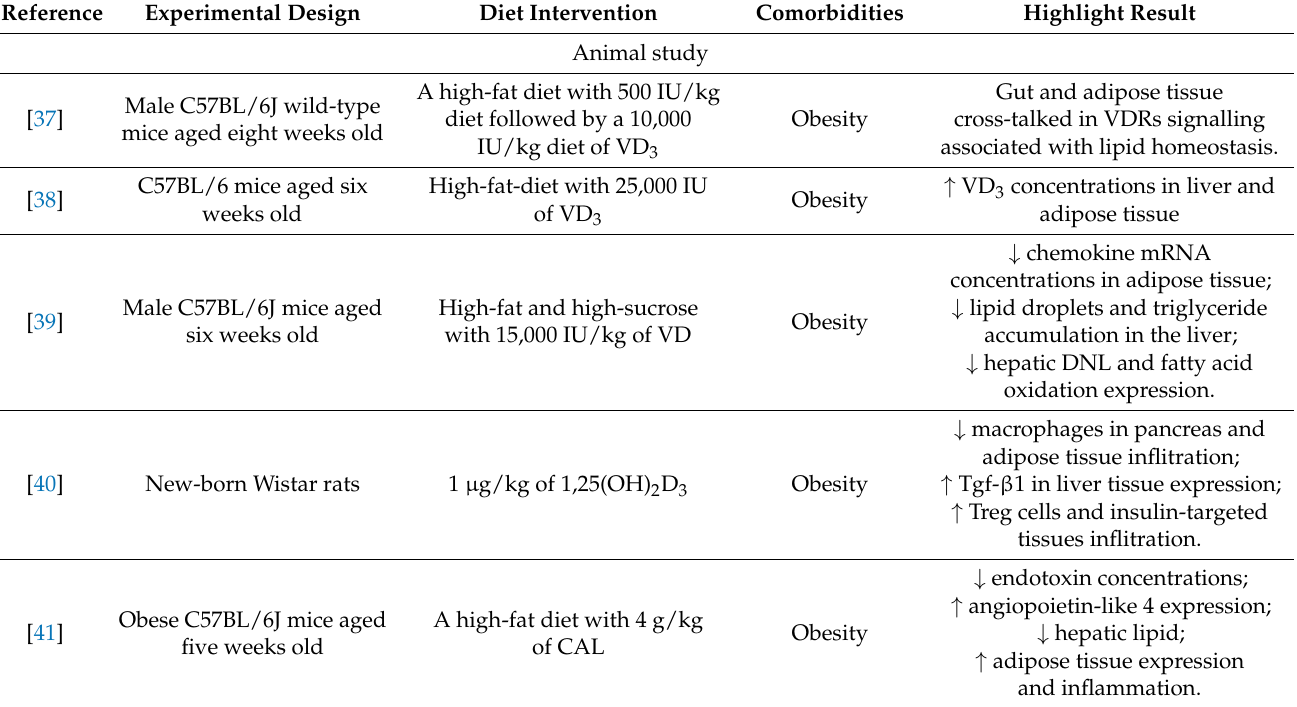
Table 2. VD–CAL in adipose tissues in animal and human